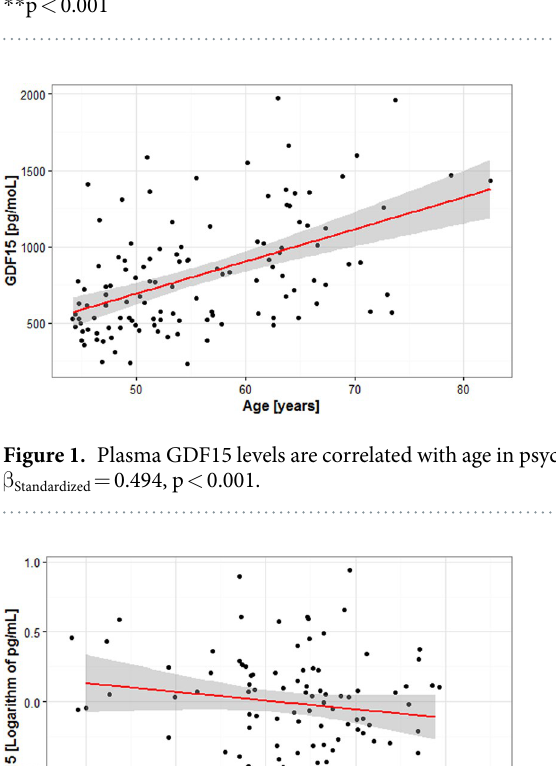
Table 3. GDF15 and high-sensitive C-reactive protein (hsCRP) levels in psychosis patients and healthy controls ** p < 0.001